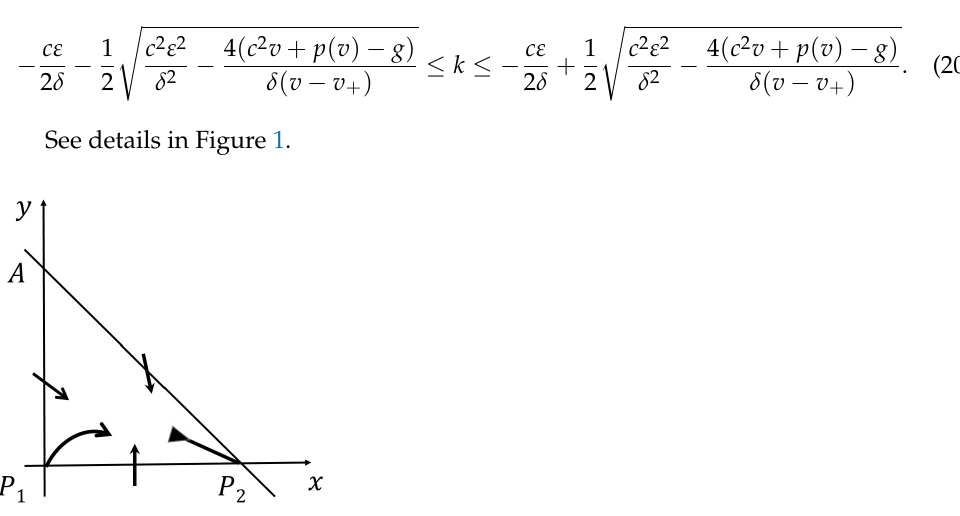
Figure 1. The tangent slopes of the orbit at P 1 A , P 1 P 2 and P 2 A